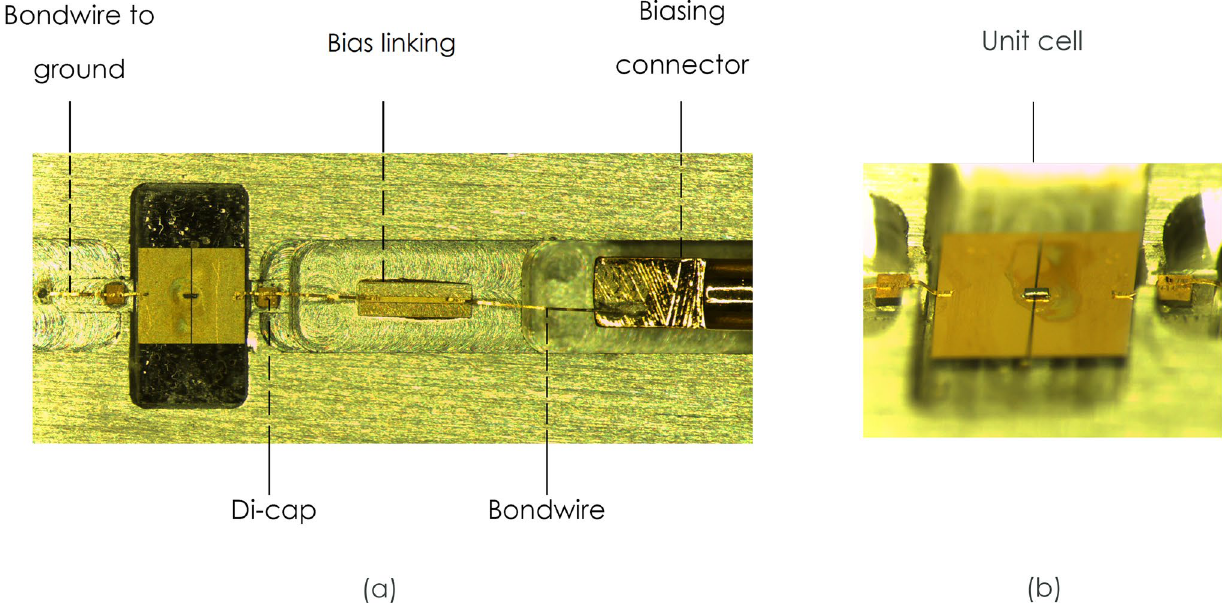
Figure 8. Photograph of fabricated metasurface unit cell inside the waveguide. ( a ) The photograph highlights the biasing supply circuit and ( b ) side view of the unit cell utilising an air-bridged Schottky